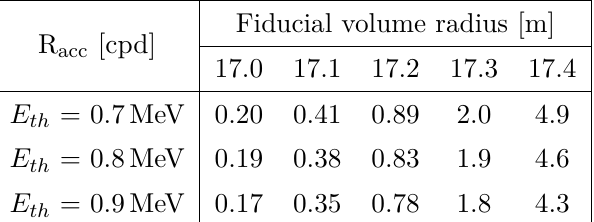
= 0.7 MeV and FV with th